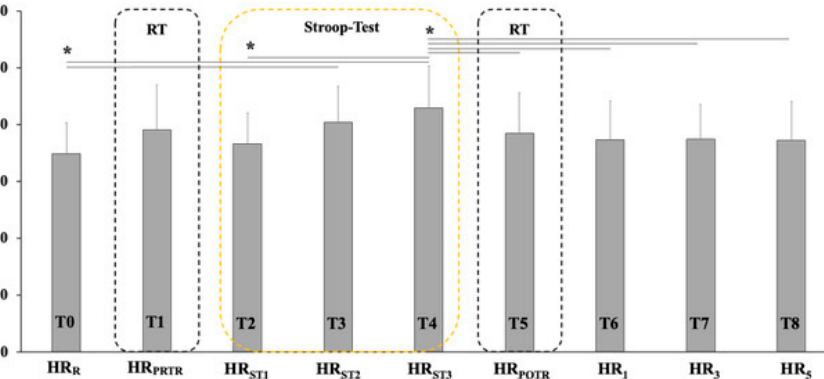
Figure 3. Heart rate in each condition of the experimental test. HR R : Frequency at rest; HR PRRT : Pre-Stroop test heart rate; HR POTR : Post-Stroop test heart rate; HR ST1 : Heart rate at 1/3 of the Stroop test; HR ST2 : Heart rate at 2/3 of the Stroop test; HR ST3 : Heart rate at the completion of the Stroop test; HR 1 :